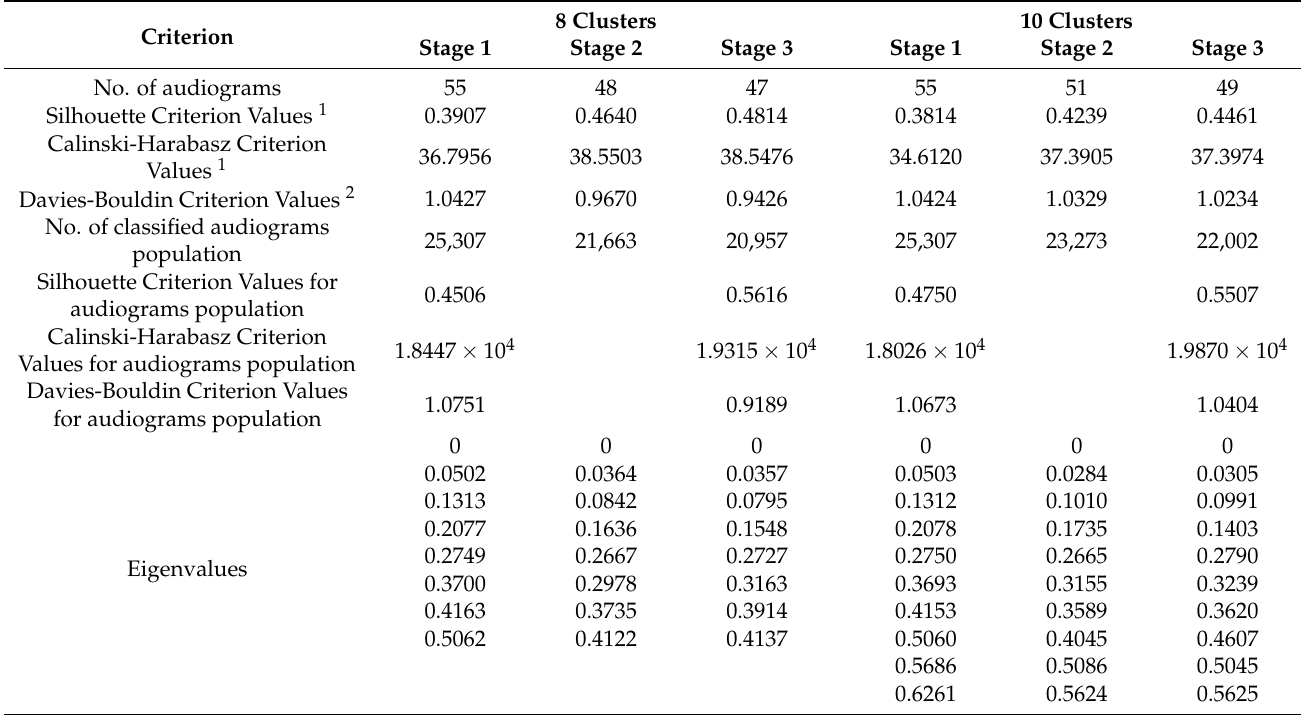
Table 7). Eigenvalues are small, but no gap is indicated to confirm selection between 8 and 10 clusters. The number of audiograms’ population considered in the last stage for 10 clusters is higher than those in 8 clusters. The 10 clusters can be preferred as more patients’ audiogram shapes are considered using 10 clusters. The Silhouette coefficients of the audiogram population are higher than 0.5 for both number of clusters, which suggests good clustering. Table 7. Summary of different clustering evaluation